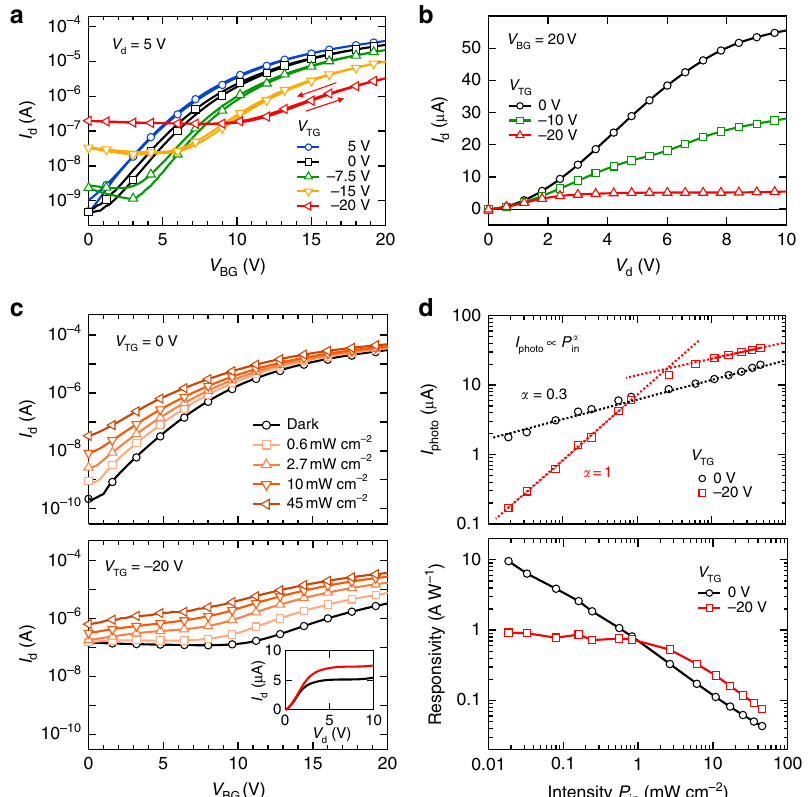
Fig. 2 Quasi-static optoelectrical characterisation of dual-gate organic phototransistor. a Transfer curves measured in dark at various top gate biases ( V TG ), with fi xed source-drain bias ( V d = 5V). The arrows indicate the scanning direction. The increasing drain current at low V BG indicates the formation of a p channel due to the accumulation of holes at the top dielectric interface when a suf fi ciently negative V TG is applied, and the threshold voltage shift of the n channel indicates that the two channels are electrostatically interacting. At V BG = 20 V and V TG = − 20 V, the drain current is mainly contributed by electrons in the bottom n channel and only partly contributed by holes in the top p channel. b Output curves measured in dark at various top gate biases ( V TG ), with fi xed bottom gate bias ( V BG = 20 V). c Transfer curves measured at various light intensities with V TG = 0 V (top) and V TG = -20 V (bottom), at V = 5 V. A positive photocurrent ( I d photo ) was generated at all gate bias conditions due to the shift in threshold voltage induced by light. Inset shows the output curve in dark (black) and in light (red) at 0.5 mWcm − 2 irradiance at V TG = − 20 V and V BG = 20 V. d Logarithmic plots showing the dependence of photocurrent (top) and responsivity (bottom) on light intensity ( P in ) at both top gate bias conditions ( fi xed V BG = 20 V). At V TG = 0 V, photocurrent scaled / P (cid:2) α sublinearly with intensity throughout the entire range displayed ( I , with slope α = 0.28 ± 0.03). At V TG = − 20 V, photocurrent switched from photo in sublinear dependence at high intensities (> 1 mW cm − 2 , slope α = 0.32 ± 0.04) to linear dependence at low intensities (< 1 mWcm − 2 , slope α = 0.97 ± 0.05). The dotted lines show the power-law fi ts. The linear scaling of photocurrent with light is re fl ected by the constant high-gain responsivity of about 1 AW − 1 , which corresponds to an external quantum ef fi ciency ( EQE ) of ~220% at 543 nm. Similar results were obtained in a dual-gate phototransistor made of DPP-DTT:PCBM blend, but with much-improved performance (~40 AW − 1 or ~9000% EQE) due to the enhanced carrier mobility in this blend